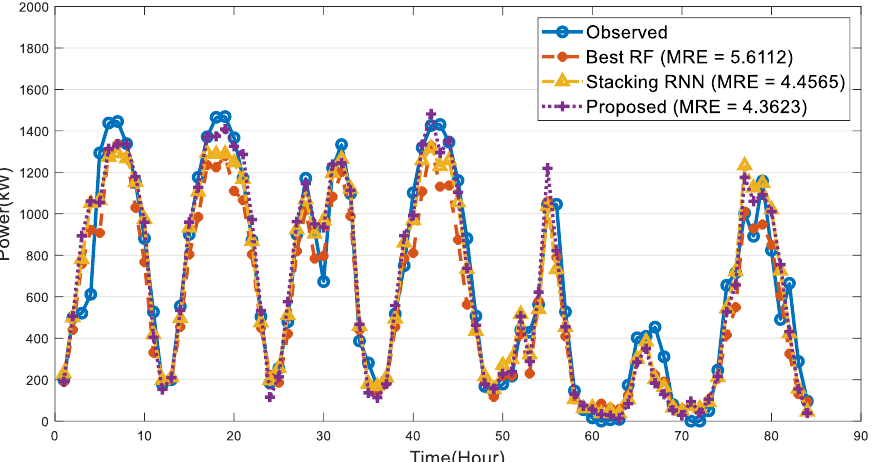
Figure 14. The comparison of the one-day-ahead PV power forecasting results for seven consecutive